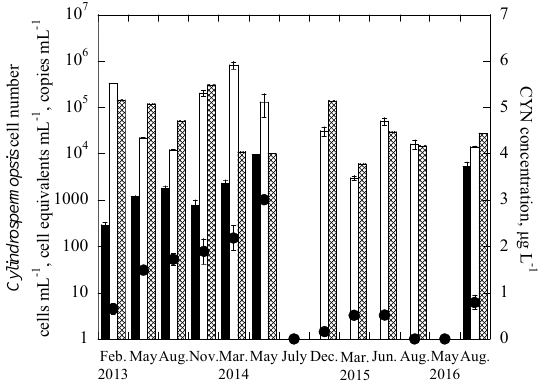
Feb. MayAug.Nov.Mar. MayJulyDec.Mar. Jun.Aug.May Aug. 2013 2014 2016 2015 Figure 3. Time course of rpo C1 gene, pks gene and cylindrospermopsin (CYN) concentrations for THR in the duplex Cylindropsermopsis system, where are the pks gene copies, is the cell equivalent of the rpo C1 gene, is the cell abundance using microscopy, and is the CYN concentration. Error bars represent standard deviation of 2 replicates.